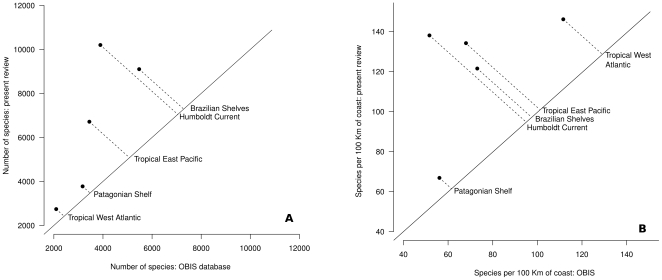
Number of species in the OBIS database versus the number of species
in the present review.A: Total number of species. B: Species per 100 km of coast. The largest
the length of the dashed line (deviation from the diagonal), the largest
the difference between the two datasets (OBIS and the present
review).